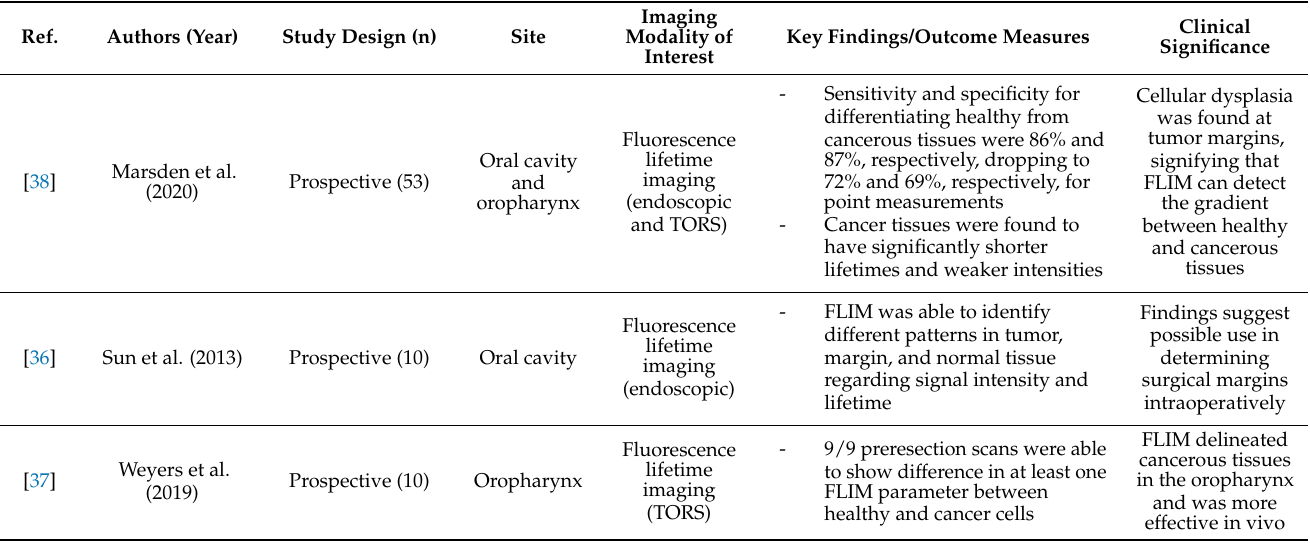
Table 4. Studies from fluorescence lifetime imaging to near-infrared fluorescence imaging.